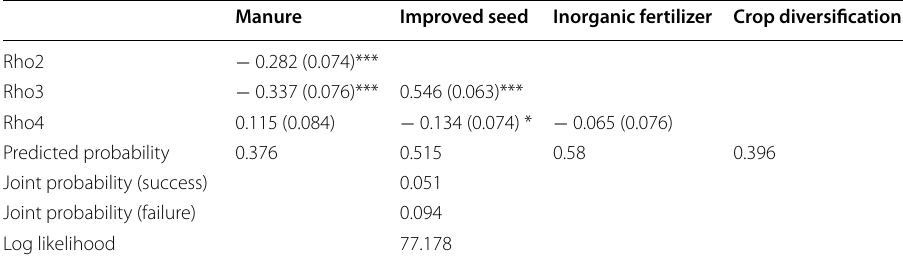
Table 3 Correlation matrix of the technologies from the multivariate probit model. Source : own calculations